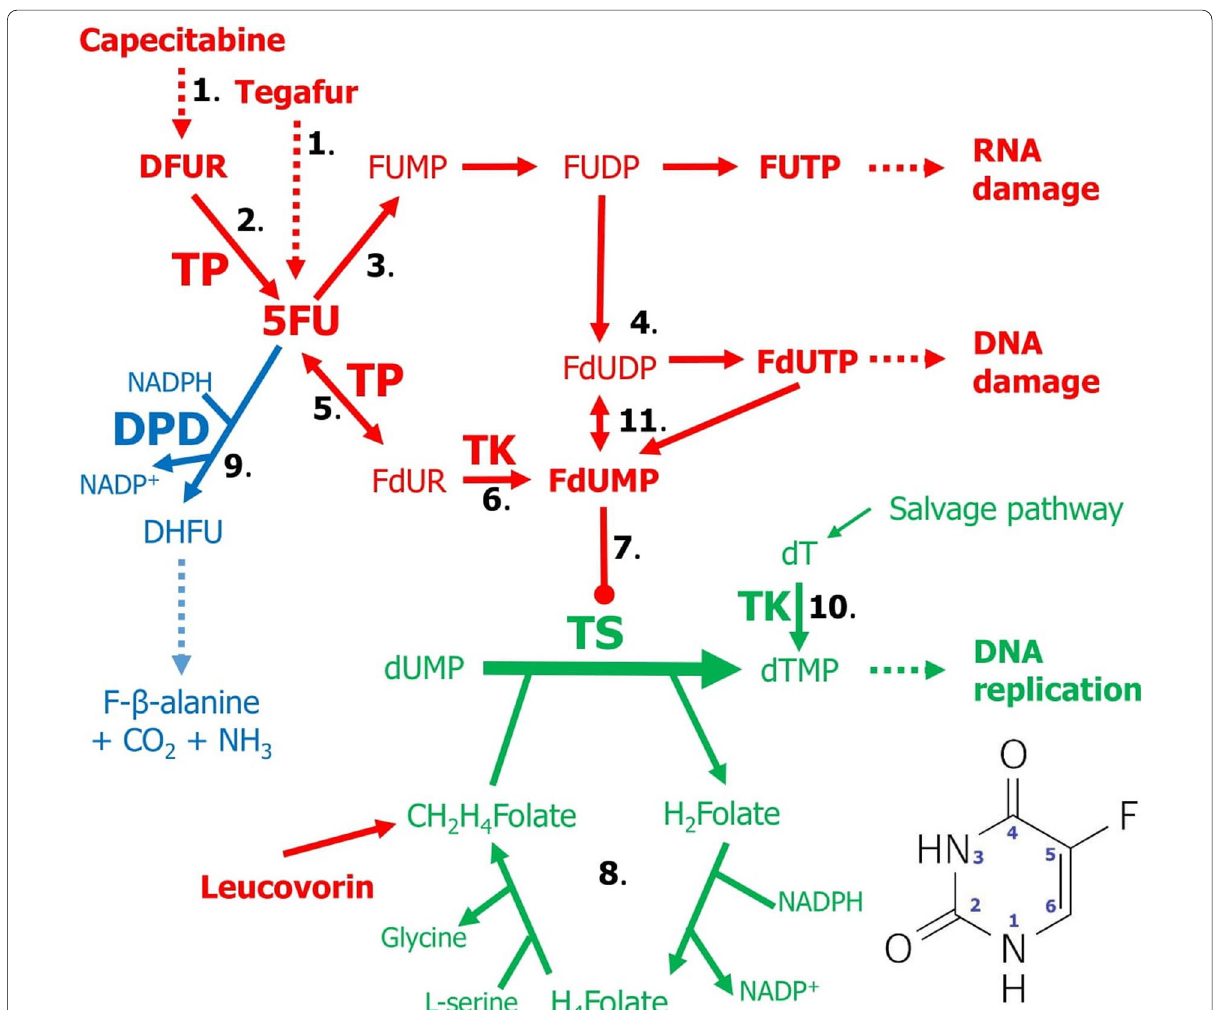
Fig. 1 5-fluorouracil (5FU) metabolism pathways. The structure and atom numbering of 5FU is shown in the lower right corner of the figure. Antimetabolite activation pathways are marked in red. The degradation pathway for pyrimidines is marked in blue. The thymidylate synthesis is marked in green. Steps in simplified metabolic pathways: 1. Capecitabine, a 5FU prodrug, is bioactivated in the liver in a two-step process to 5’-deoxy-5-fluorouridine (doxifluridine; DFUR), while tegafur, another 5FU prodrug, is bioactivated by CYP2A6. 2. DFUR is converted to 5FU by thymidine phosphorylase (TP). 3. 5FU is sequentially converted to 5-fluorouridine monophosphate (FUMP), diphosphate (FUDP) and triphosphate (FUTP), which is an active metabolite that is mistakenly incorporated into RNA, causing RNA damage. 4. FUDP is also sequentially converted to 5-fluoro-2’-deoxyuridine diphosphate (FdUDP) and triphosphate (FdUTP), which is an active metabolite that is mistakenly incorporated into DNA, causing DNA damage. 5. TP converts 5FU to 5-fluoro-2’-deoxyuridine (FdUR). 6. Thymidine kinase (TK) converts FdUR to 5-fluoro-2’-deoxyuridine monophosphate (FdUMP). 7. FdUMP is an active metabolite that irreversibly inhibits thymidylate synthase (TS), an enzyme that catalyzes the conversion of 2’-deoxyuridine monophosphate (dUMP) to 2’-deoxythymidine monophosphate (thymidylate; dTMP). 8. Cyclically dihydrofolate (H 2 Folate) is reduced to tetrahydrofolate (H 4 Folate) which is then converted to 5,10-methylenetetrahydrofolate (CH 2 H 4 Folate). Leucovorin (folinic acid) is converted to CH 2 H 4 Folate and then stabilizes the bond formed between TS and FdUMP. 9. Dihydropyrimidine dehydrogenase (DPD) catalyzes the first step of the breakdown of 5FU (mainly in the liver) to 5,6-dihydro-5-fluorouracil (DHFU), which is further broken down into α-fluoro-β-alanine, carbon dioxide and ammonia, excreted from the body. 10. Thymidylate can be salvaged by TK from thymidine (dT) derived from dead cells. 11. FdUTP can be converted to FdUMP by dUTP pyrophosphatase and then converted back to FdUDP by UMP-CMP kinase. Based on information from Longley et al. (2003) and maps in KEGG (Kanehisa et al.